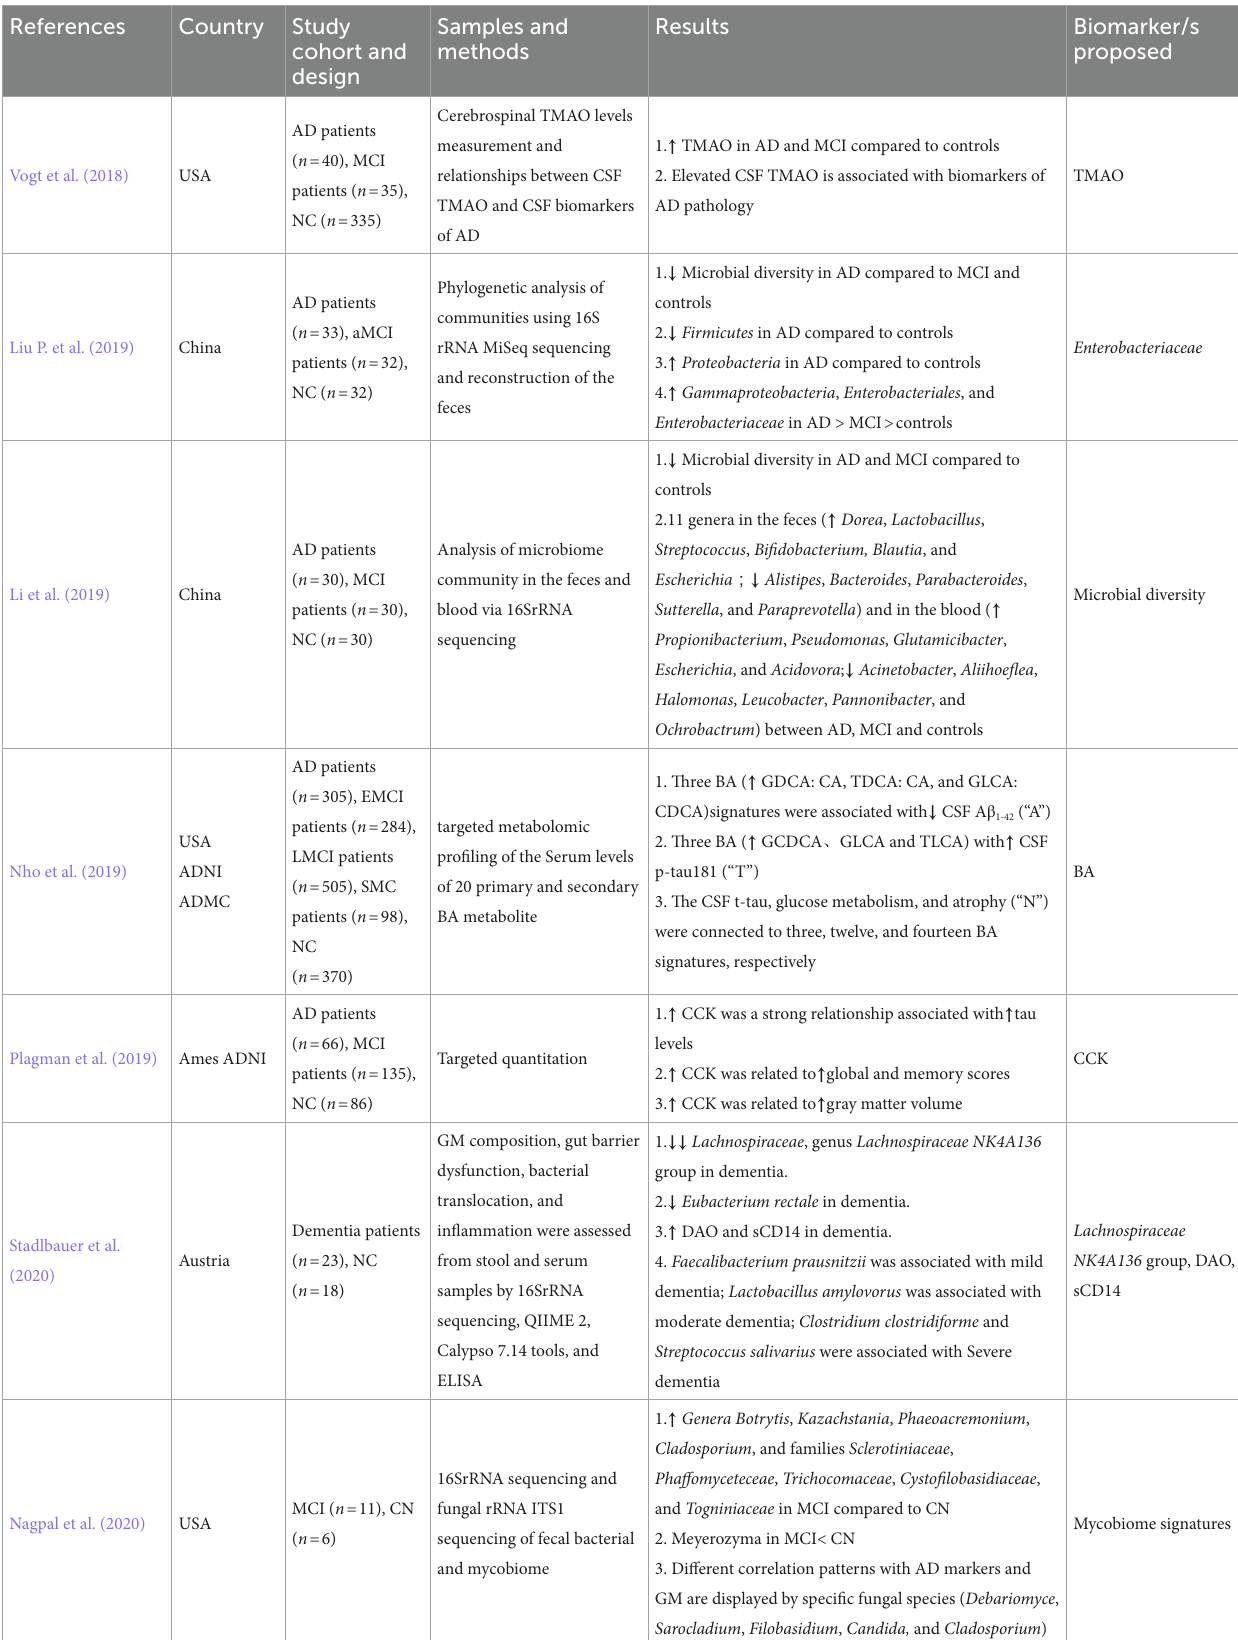
TABLE 1 Microbiome-based biomarkers in humans ( ↑ : increase; ↓ : decrease; ↑↑ : significant increase; ↓↓ ;